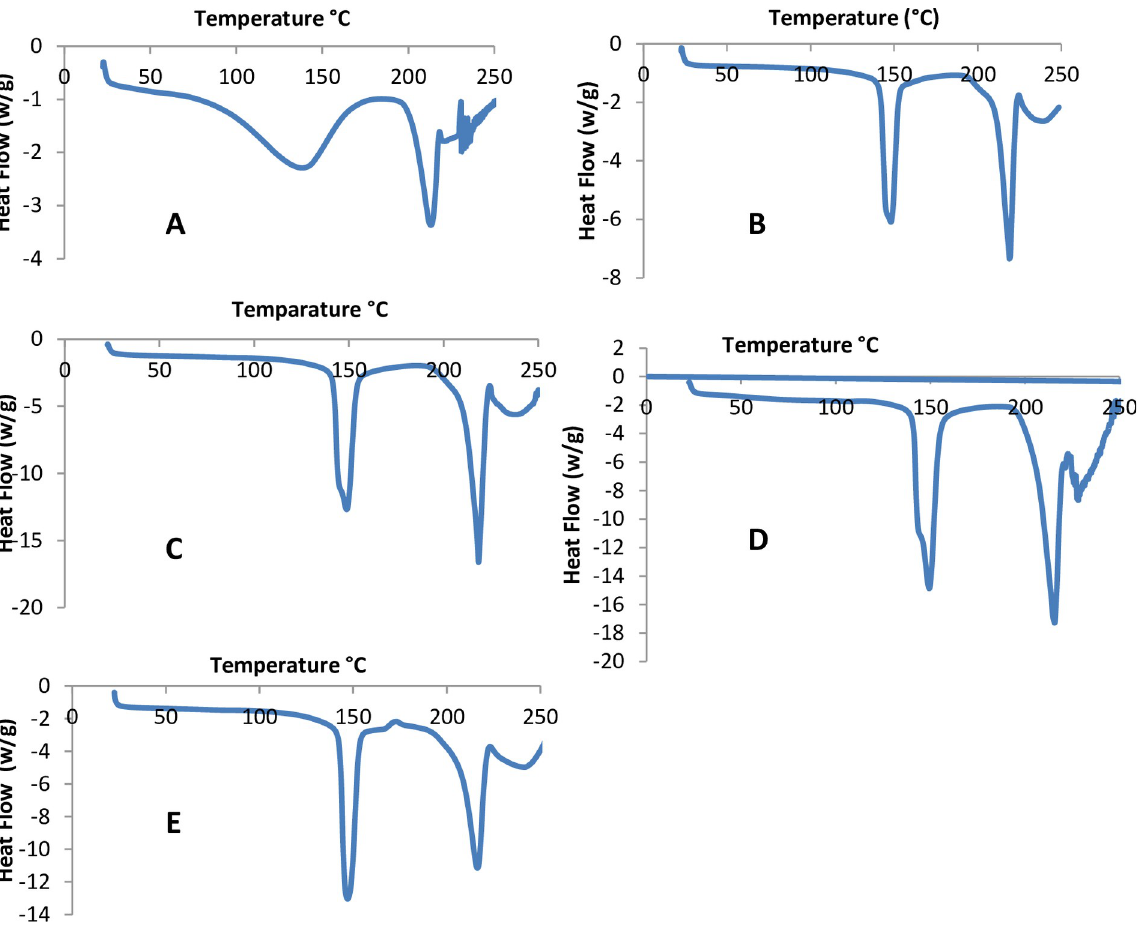
Fig 2. The DSC thermograms of DSC scan of Puerarin (A), Lactose (B), Puerarin and Lactose (C), Puerarin, MgSt and Lactose (D), and Puerarin, Lactose and Leucine (E).